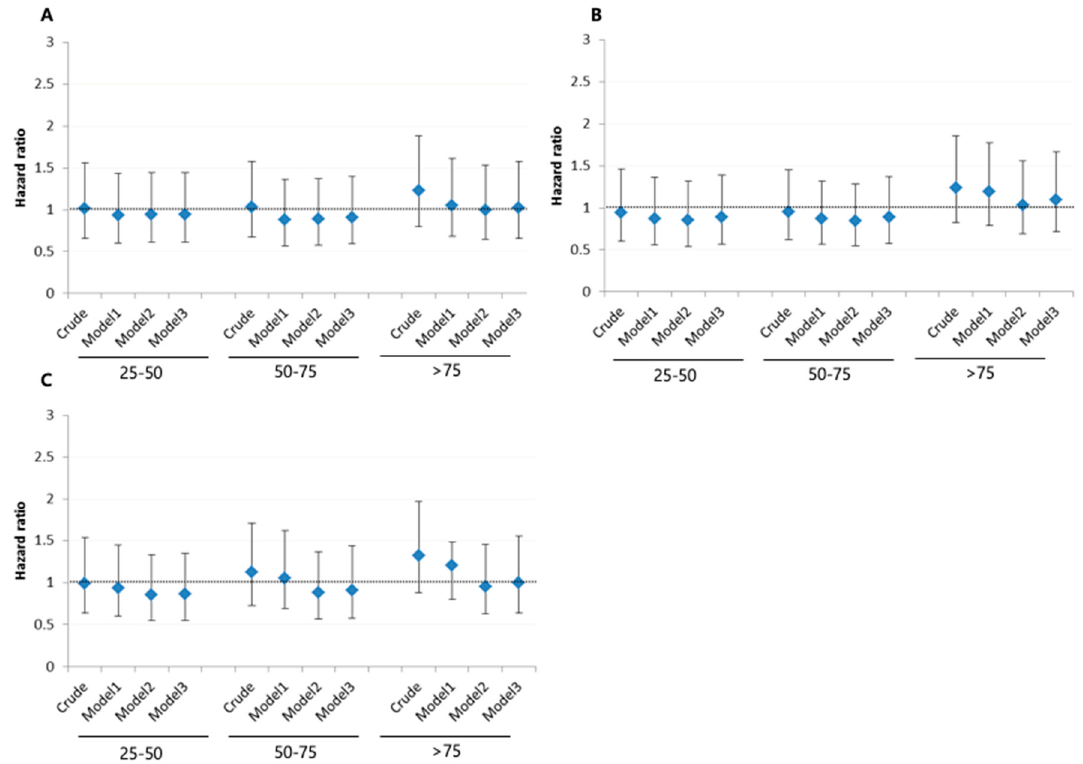
Figure 3. Hazard ratio (95% confidence interval) for the incident of cerebrovascular diseases according to the ( A ) AST, ( B ) ALT, and ( C ) gamma-glutamyltransferase (GGT). Model 1: sex, age. Model 2: model 1 + hypertension, diabetes mellitus, hyperlipidemia, cardiovascular disease, smoking and alcohol status, and body mass index. Model 3: model 2 + metabolic equivalent of task, cancer, hyperlipidemia drug, antihypertension drug, and the metabolic equivalent of task. Estimated from Cox’s proportional hazard regression model.